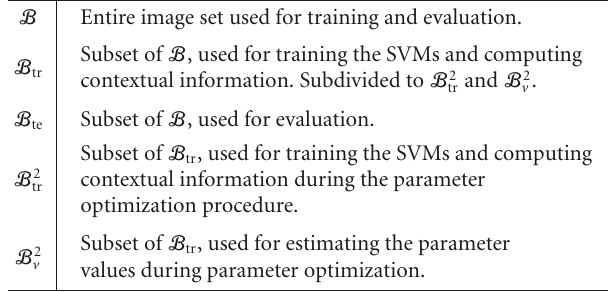
Table 1: Table of training and test sets.